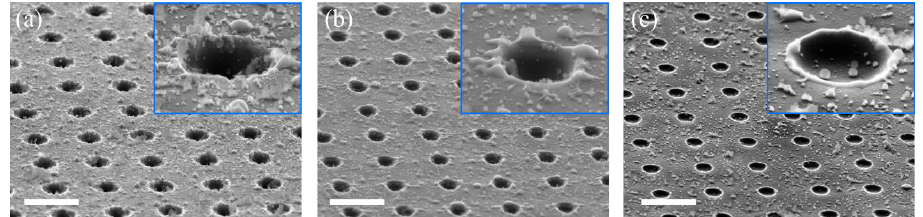
Figure 2. SEM image of GaSe surface with an ARM, inscribed at Е = 8.4 nJ and numbers of pulses: 8 ( a ), 3 ( b ), 1 ( c ). Scale bar —3 µm. One of the craters is shown separately in the upper right corner of each image.